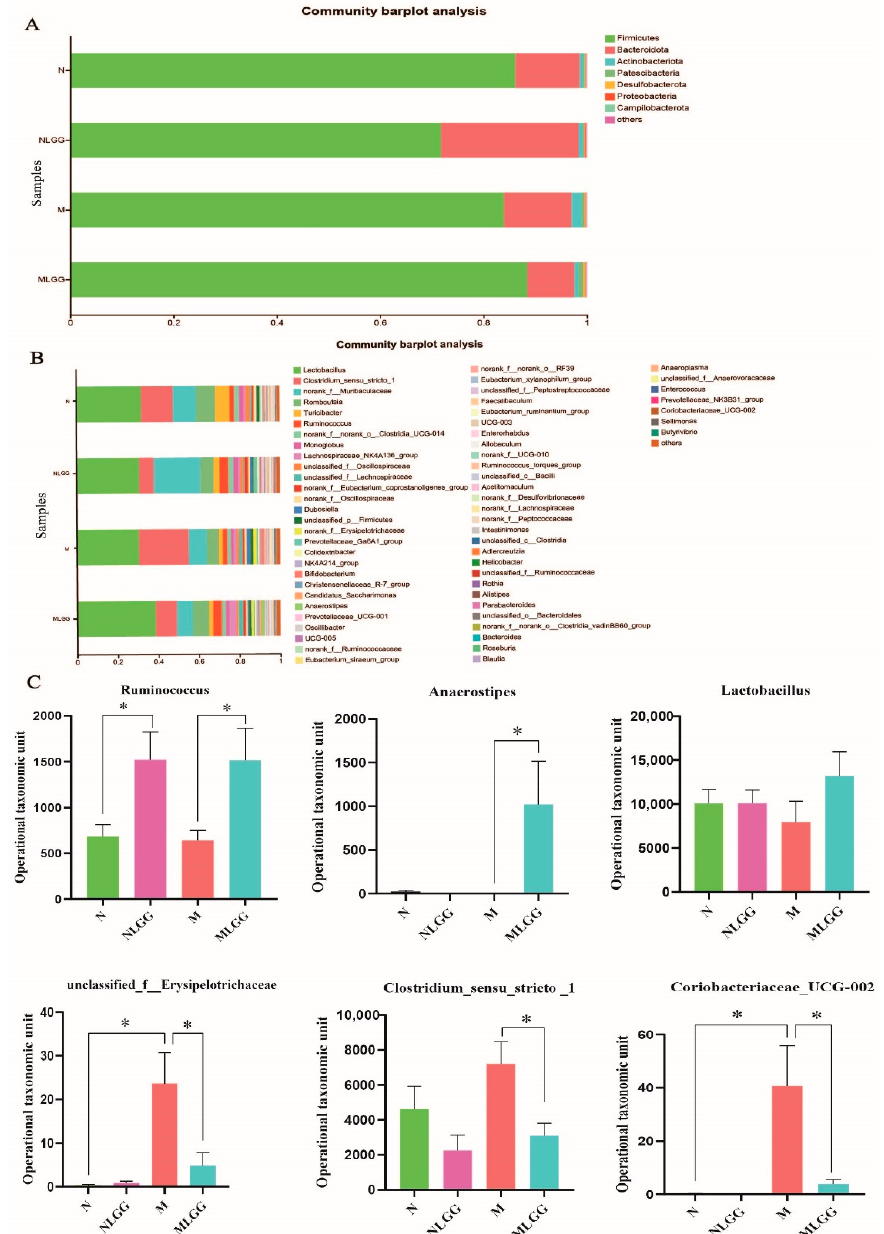
Figure 6. Structural modulation of gut microbiota in the control group (N group), the control group supplemented with Lactobacillus rhamnosus R0011 ( L. rhamnosus R0011) (NLGG group), the CCl 4 - induced chronic liver injury model (M group), and the model group supplemented with L. rhamnosus R0011 (MLGG group). ( A ) Phylum-level gut microbiota profile. ( B ) Genus-level gut microbiota profile. ( C ) Alterations in the relative abundance of bacterial taxa. Data are presented as the mean ± SEM ( n = 6). One-way ANOVA was used to evaluate differences between groups (* p < 0.05).